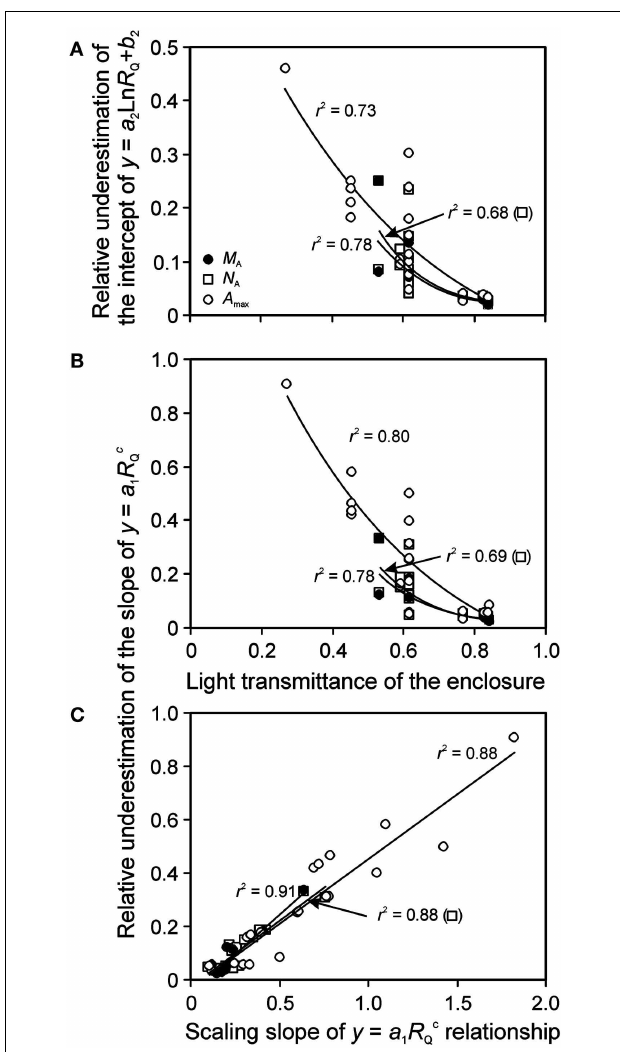
FIGURE 7 | Bias introduced by lack of consideration of reduction of light by enclosure on the shape of leaf structure, chemistry, and physiology vs. relative light ( R Q ) relationships. Correlations of (A) the relative underestimation of the intercept ( b 2 ) of y = a 2 Ln( R Q ) + b 2 (Eq. 17) and (B) the relative underestimation of the slope ( a 1 ) of y = a 1 R Q c (Eq. 16) by using the apparent relative light ( R Q,A ) with the light transmittance of the enclosure, and the correlation between the slope ( a 1 ) and scaling exponent (C) of y = a 1 R Qc across the studies investigating within-canopy variation in foliage characteristics in greenhouses ( Table 1 for the studies included).The relative change is defined as [ p j ( R Q ) − p j ( R Q,A )]/ p j ( R Q ), where p j refers to a given regression parameter. In addition to leaf nitrogen content per area ( N A ) and photosynthetic capacity ( A max ), bias in leaf dry mass per unit area ( M A ) relationships is also analyzed.The correlations were fitted by non-linear or linear regressions whichever provided the best fit (all regressions are significant at P < 0.001). Data sources are provided in Table 3